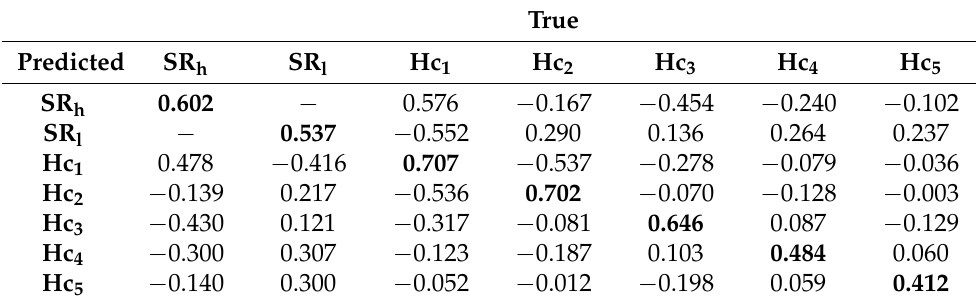
Table 6. Correlation coefficients 1 (accuracies) between predicted breeding values for SR or for haplotype allele content and their corresponding true values in ungenotyped individuals.